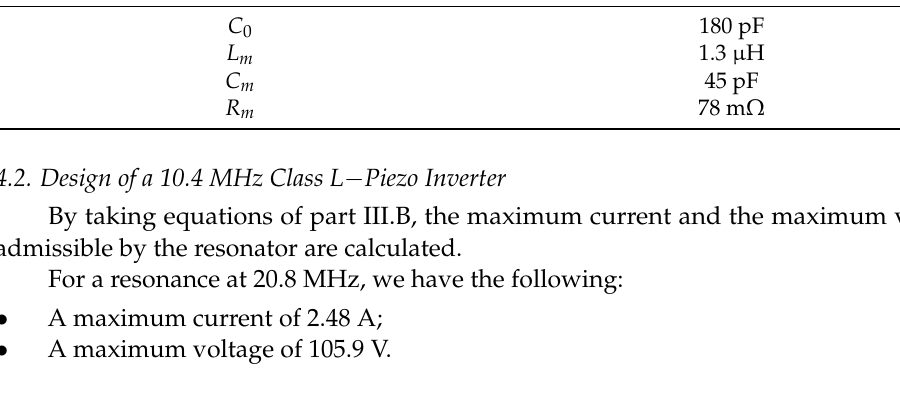
Table 2. Values of the model of the piezoelectric resonator.